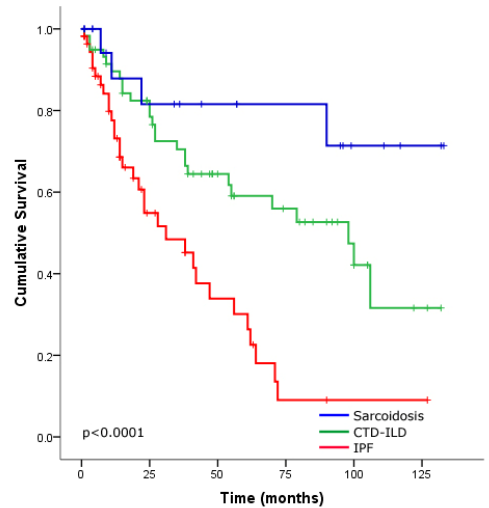
Figure 2. Kaplan–Meier survival estimates for interstitial lung disease (ILD) patients with pulmonary hypertension according to the underlying disease idiopathic pulmonary fibrosis (IPF) (red line), connective tissue disease (CTD) associated ILD (green line) and sarcoidosis (blue line). Survival in the entire ILD-PH cohort (with PH and severe PH) revealed that physiological and hemodynamic parameters were predictors of worse outcome, including DLco < 35% predicted ( p = 0.001 by log-rank analysis; Figure 3A), 6MWT final SpO 2 < 88% ( p = 0.024 by log-rank analysis; Figure 3B) and PVR ≥ 4.5 WU ( p = 0.024 by log-rank analysis; Figure 3C). However, 6MWD < 300 m was not associated with a worse outcome ( p = 0.160 by log-rank analysis; Figure 3D).